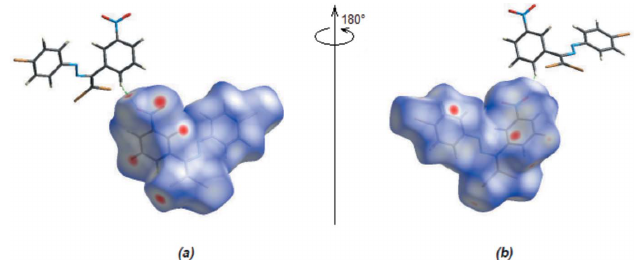
Figure 5 ( a ) Front and ( b ) back views of the three-dimensional Hirshfeld surface of the title compound plotted over d norm in the range (cid:4) 0.1471 to 1.1715 a.u.